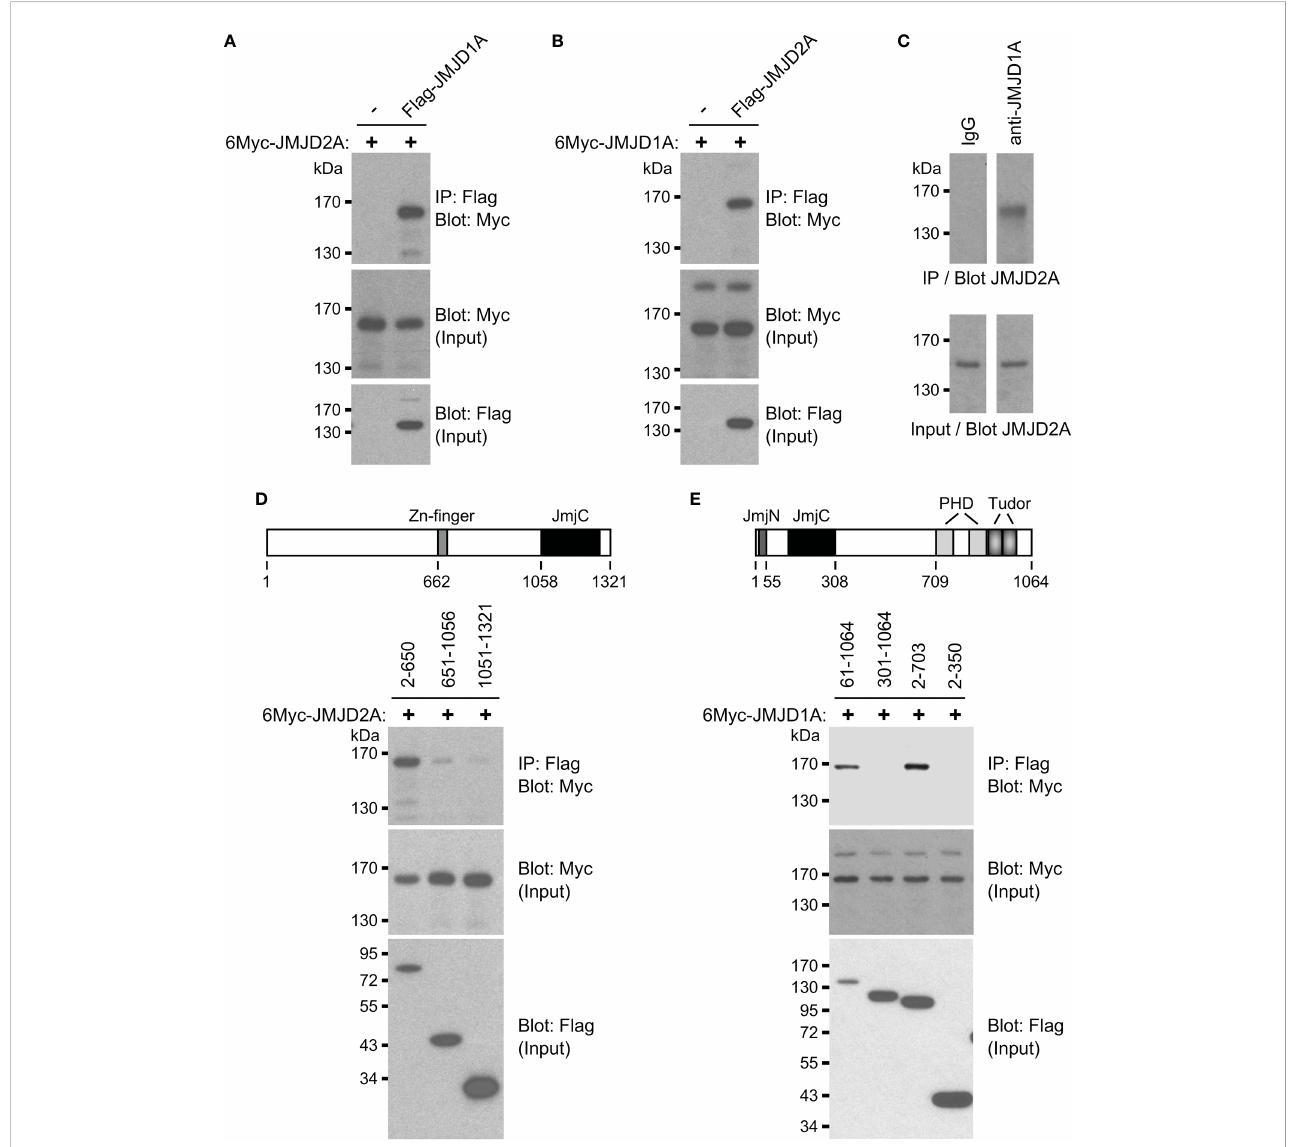
FIGURE 3 Complex formation between JMJD1A and JMJD2A. (A) Coimmunoprecipitation experiment with 6Myc-JMJD2A and Flag-JMJD1A in 293T cells. The top panel shows immunoprecipitation (IP) with anti-Flag antibodies followed by anti-Myc Western blotting, while the bottom two panels show input levels for 6Myc-JMJD2A and Flag-JMJD1A. (B) Likewise, interaction between 6Myc-JMJD1A and Flag-JMJD2A. (C) Endogenous coimmunoprecipitation of JMJD2A with JMJD1A in HCT116 cells. Either control IgG or anti-JMJD1A antibody was used for immunoprecipitation. (D) Coimmunoprecipitations of indicated Flag-tagged JMJD1A amino acids with 6Myc-JMJD2A. Top shows a sketch of JMJD1A. (E) Coimmunoprecipitation of 6Myc-JMJD1A with indicated Flag-tagged JMJD2A amino acids. Top shows a sketch of